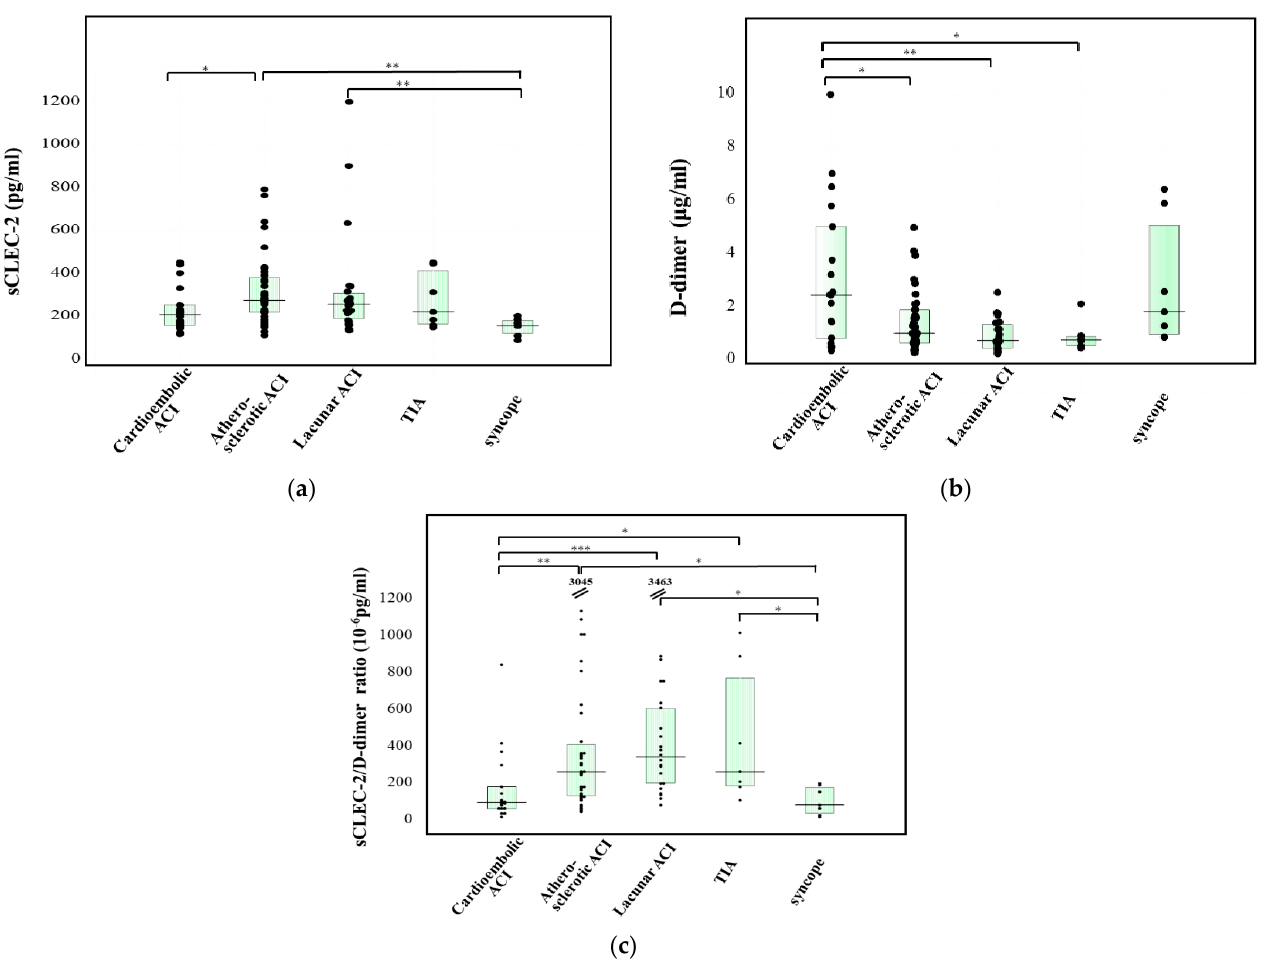
Figure 2. The plasma levels of sCLEC-2 ( a ), and D-dimer ( b ), and the CLEC-2/D-dimer ratio ( c ) in patients with cardioem- bolic ACI, with atherosclerotic ACI, with Lacunar CI, with TIA, or with syncope. ACI, acute cerebral infarction; *** p < 0.001; ** p < 0.01; * p < 0.05; The numbers in ( c ) indicated sCLEC-2/D-dimer ratio ≥ 1200.